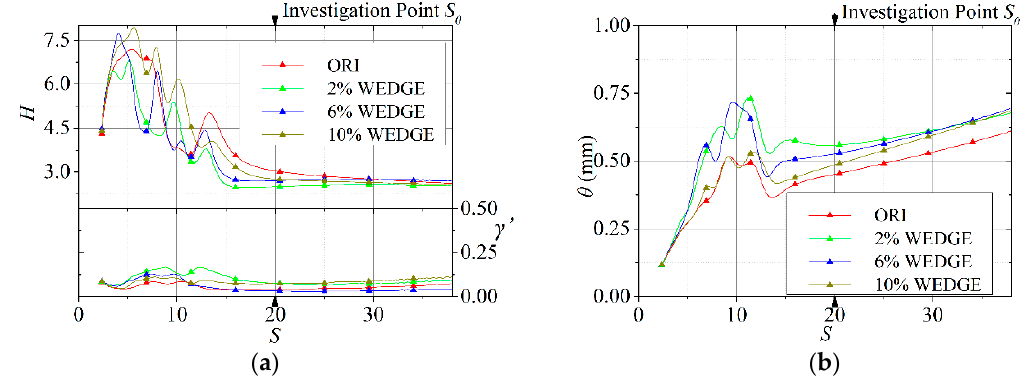
Figure 6. The WEDGE of Ellip.LE at Tu = 0: ( a ) the boundary layer shape factor and normal average turbulence intermittency; ( b ) the momentum thickness along aerofoils.